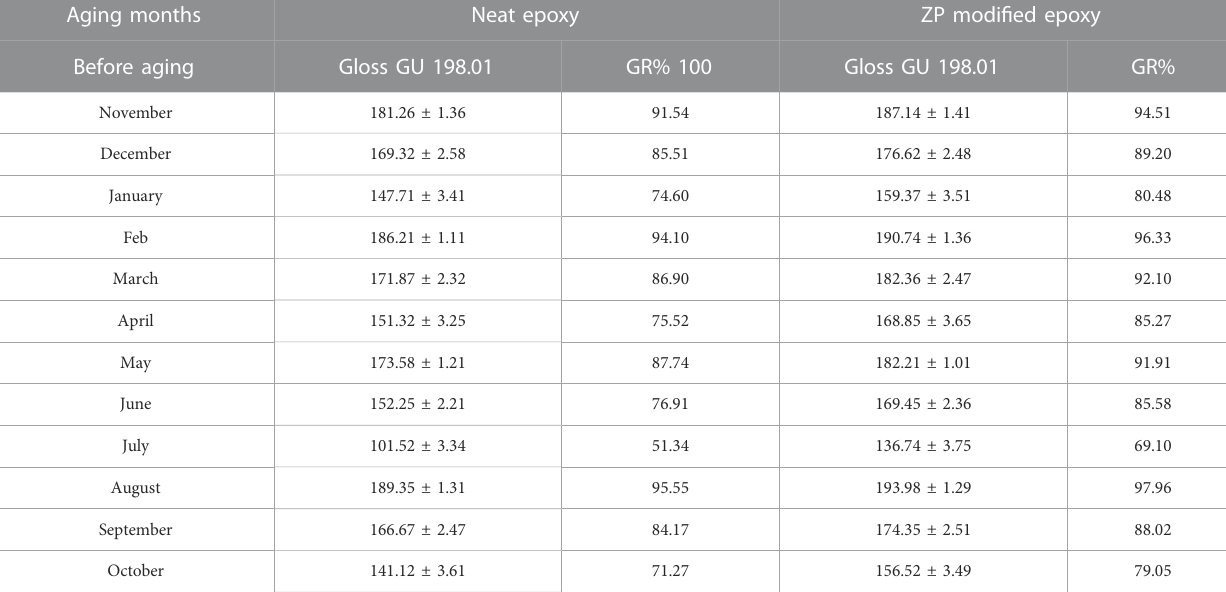
TABLE 6 Mean and standard deviation values of the gloss retention of both neat and ZP-modi fi ed epoxy coatings. Aging